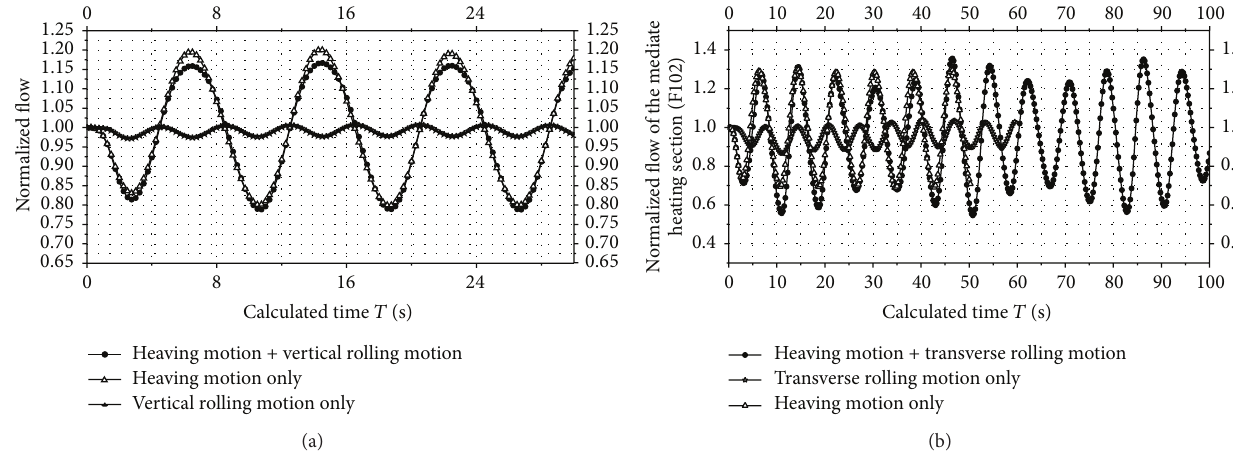
Figure 12: Effect of heaving motion with strength 0.6 g and cycle 8s, vertical rolling with swing angle 22.5 ∘ and cycle 8s, and compound motions consisted of the above two movements on the normalized flow of natural circulation.